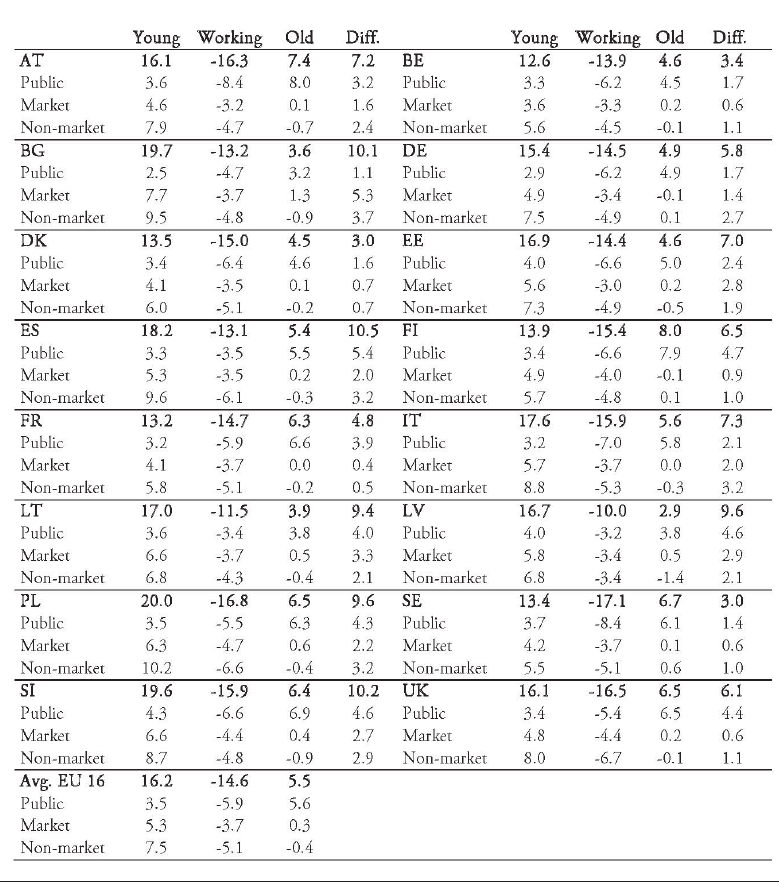
Table 2: Simulation of intergenerational transfers by life stage and type. Based on the 2010 transfer and mortality